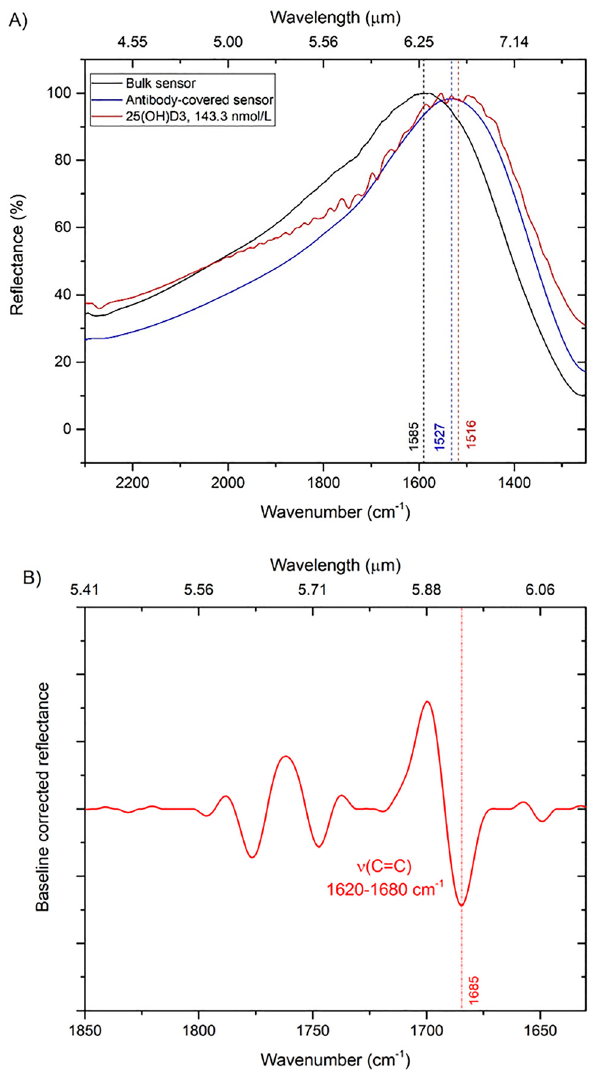
Figure 6: SEIRA spectra. (A) Reflectance curves (black: naked sensor;blue:sensorwithadsorbedantibodymonolayer;red:sensor with bound 25(OH)D3 with a concentration of 143.33 nmol/L) pertaining to pixel CS 1,2 (L = 1.1 µm, P = 2.0 µm, W = 200 nm). (B) Baseline-corrected re fl ectance with the detected molecular vibration, i.e., stretching of the carbon double bond ν (C=C), vibrating in the range 1620 – 1680 cm − 1